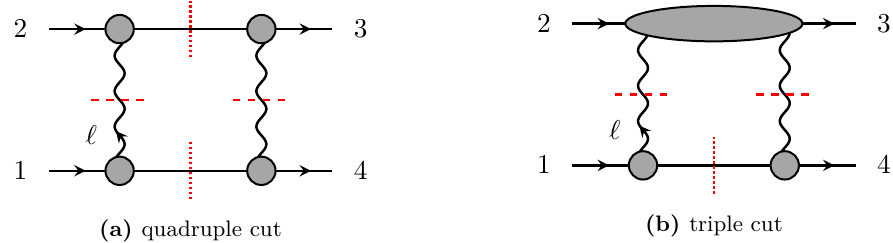
Figure 2. Here are the unitraity cuts used to extract the corresponding integral coefficients. The dashed lines represents cuts from gluing two four-point tree Compton amplitudes (the double cut) and the dotted line is the additional cuts imposed to get the desired cuts. The solid and wavy lines represent spinning bodies and gravitons,